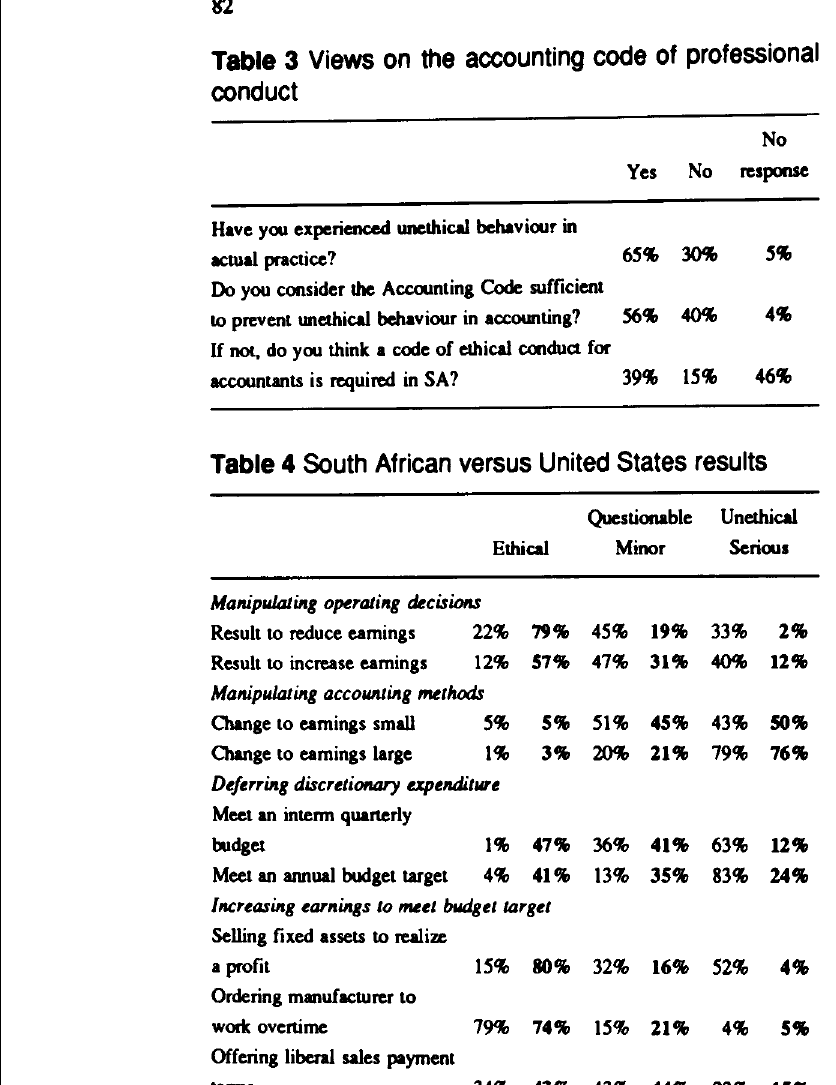
Table 3 Views on the accounting code of professional